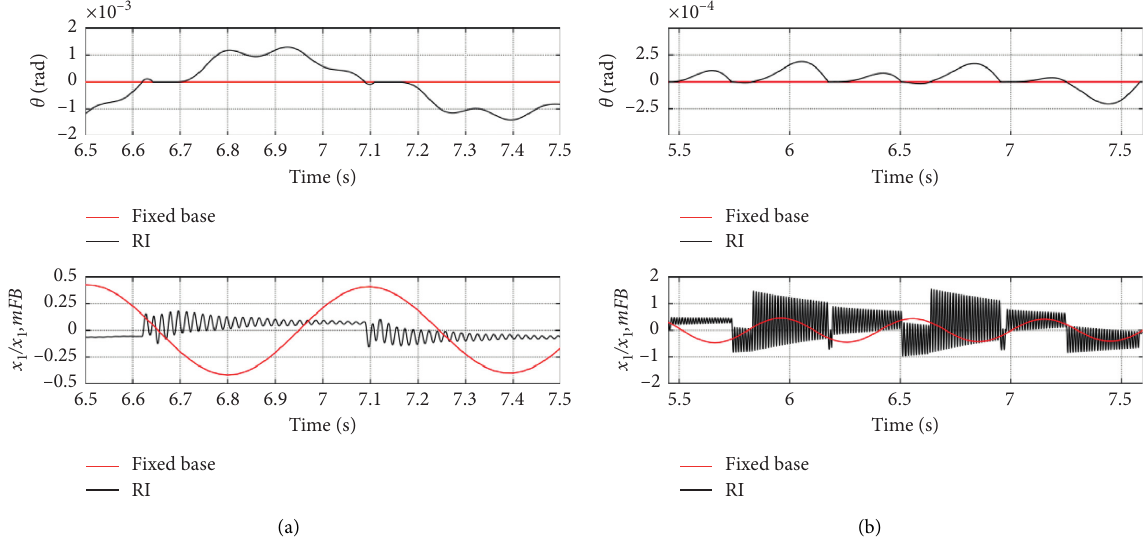
Figure 10: Zoomed-in views of the high-frequency vibrations of flexibility components in Figure 9 for the system with C1 (a) and C2